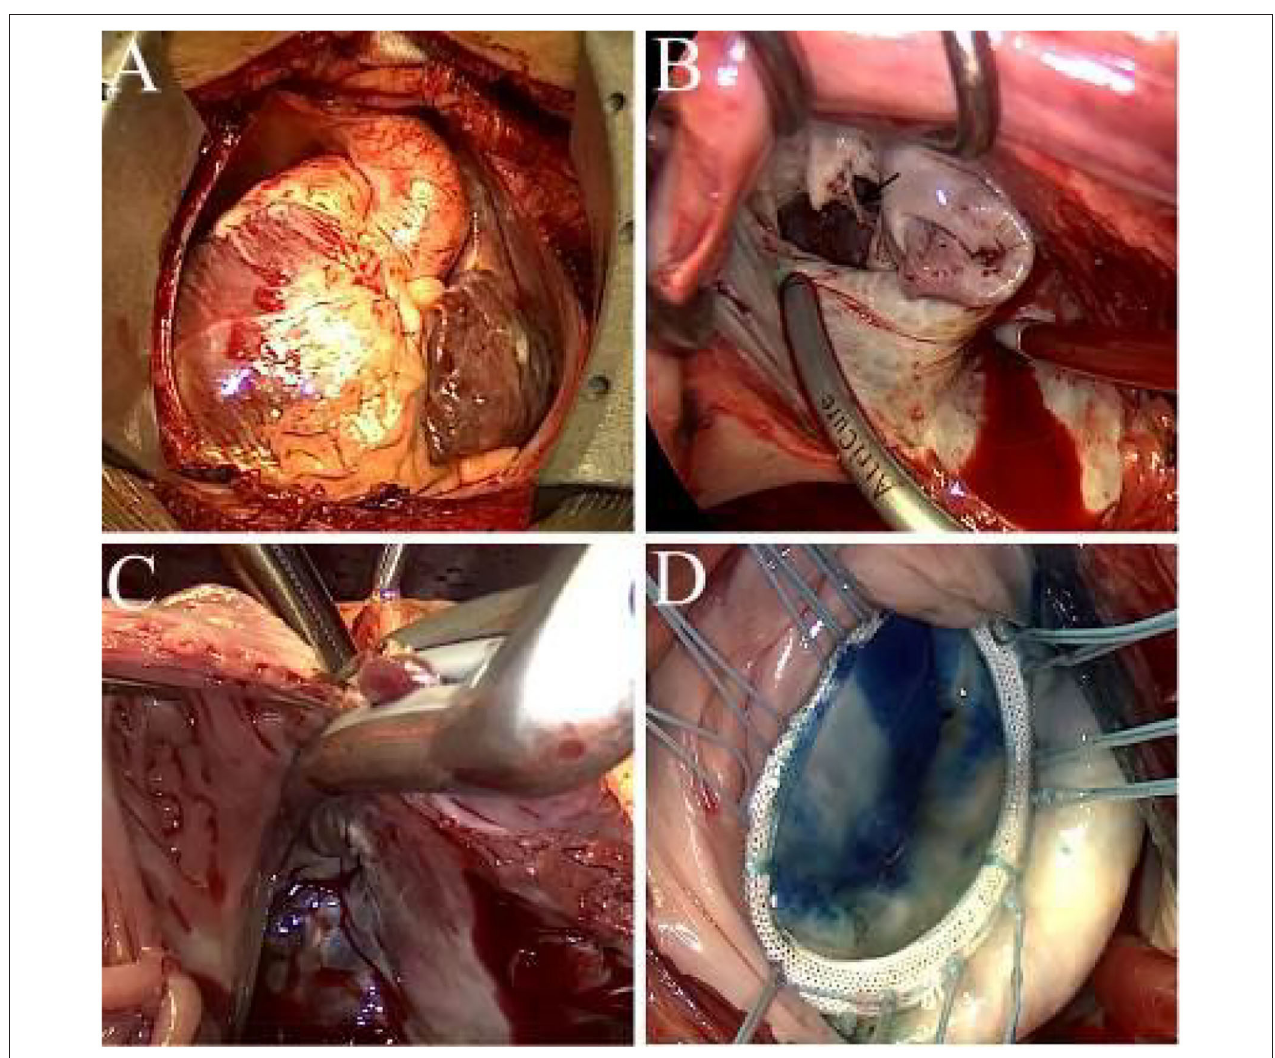
FIGURE 3 | (A) Intraoperative view of the mirror-image dextrocardia. (B) Ablation at the mitral line, black arrow indicates the ruptured chordae. (C) Ablation to the tricuspid annulus, the jaw of the bipolar clamps are placed across the tricuspid annulus. (D) Successful result of saline injection test after mitral valvuloplasty.